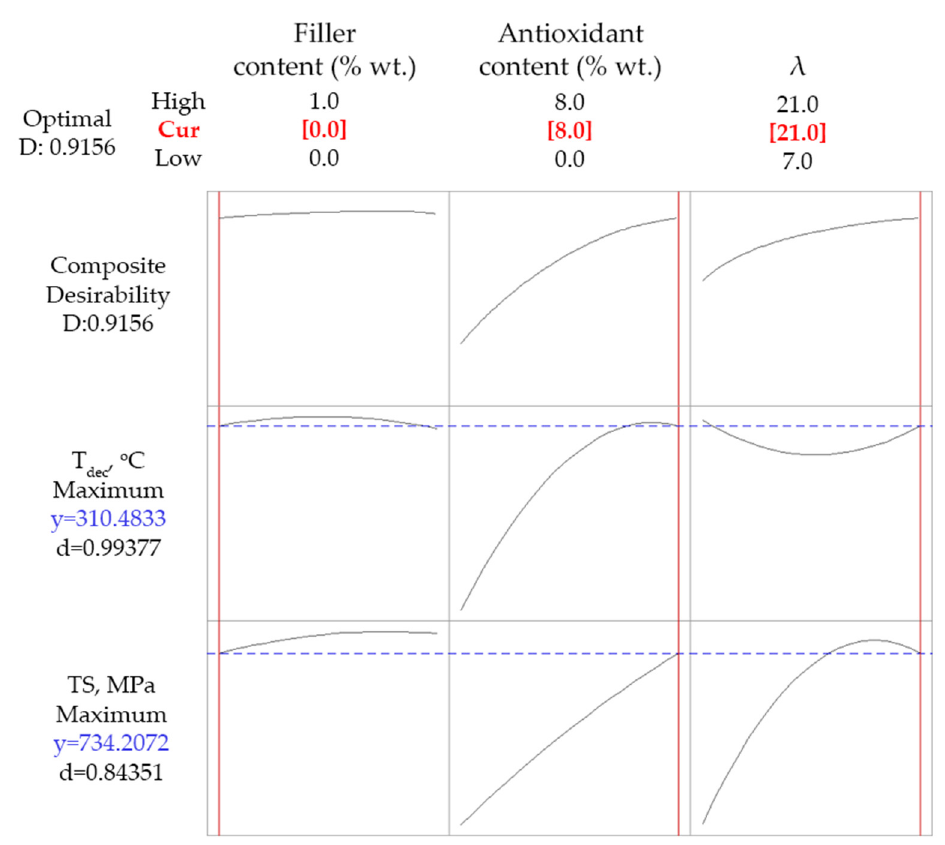
Figure 10. Constrained optimization results for simultaneous maximization of TS and T dec , imposing the absence of SWCNTs.